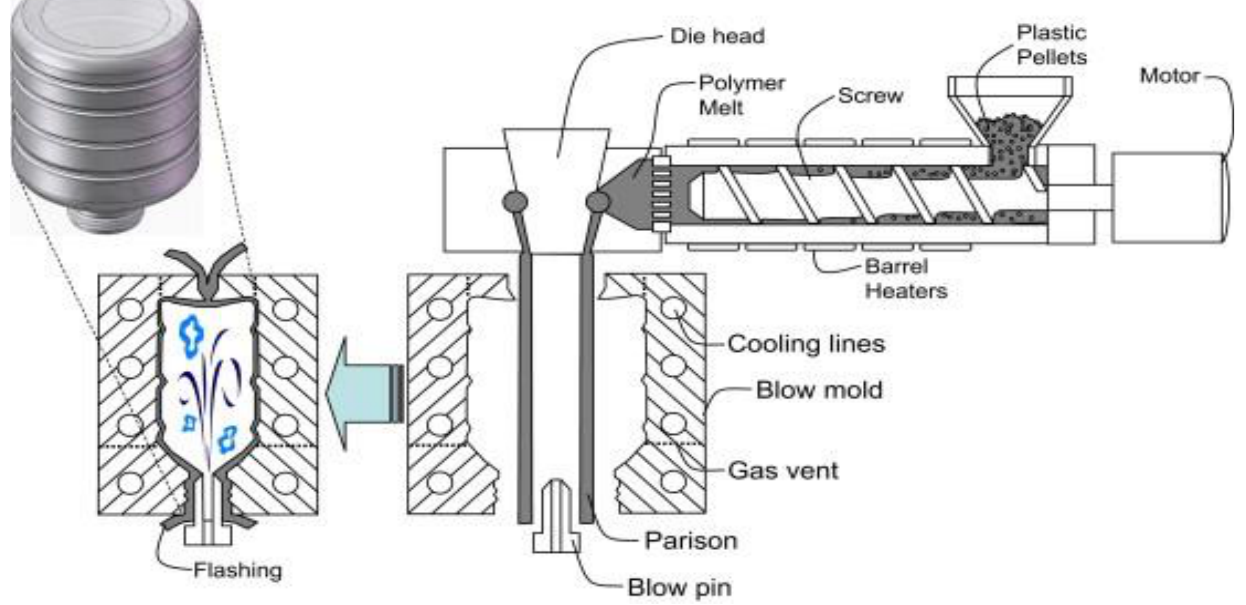
Figure 4 . Plastic blow molding process. Reproduced from ref. [36] with permissions from Elsevier. 2017.